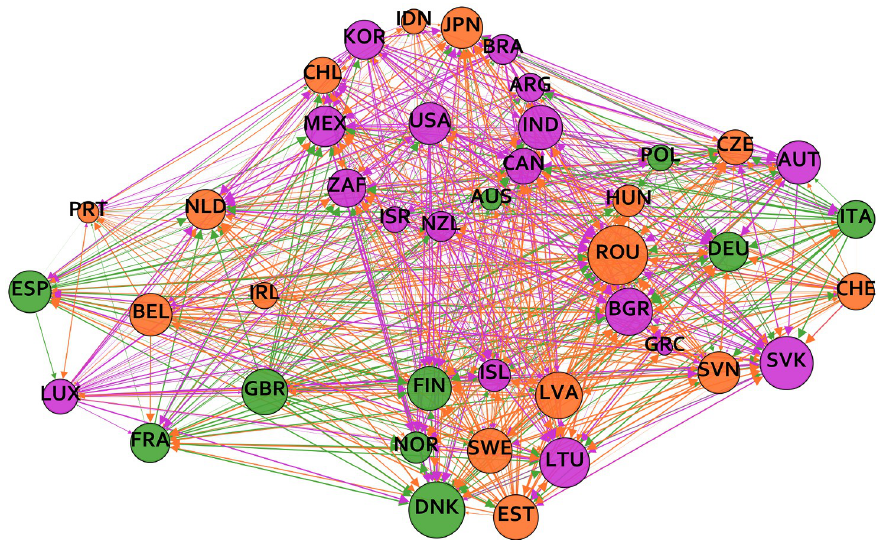
Fig 1. Weighted shock contagion network. The nodes of the graph are countries and the directed weighted edges refer to the frequency of observed shock transmission between countries. The color of the nodes reflects the module membership and the size of the nodes refer to the total degrees of countries.